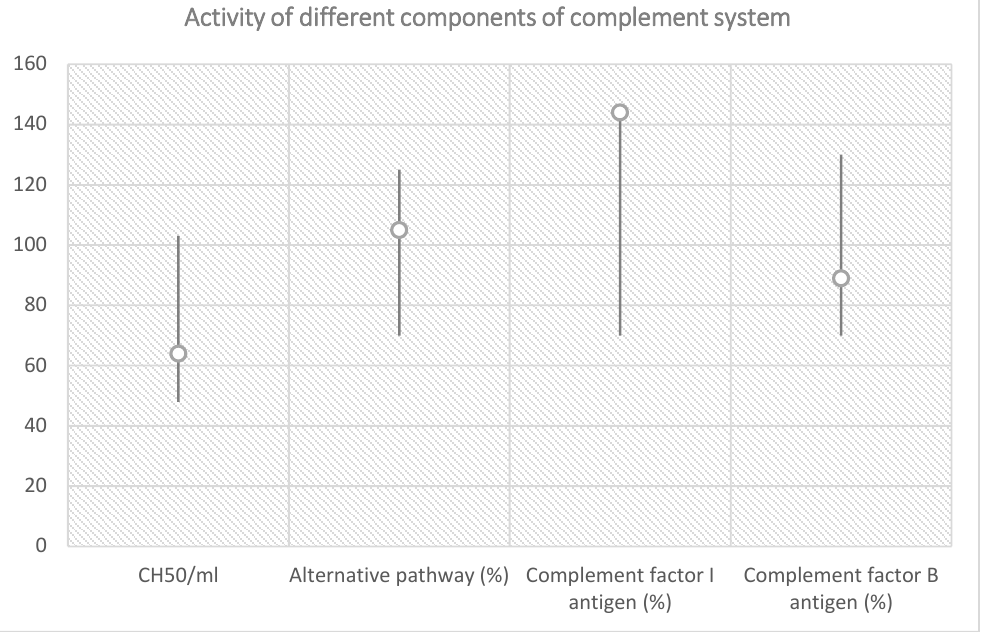
Figure 4. Classical pathway, alternative pathway, complement factor I and factor B antigen activity in relation with reference range.